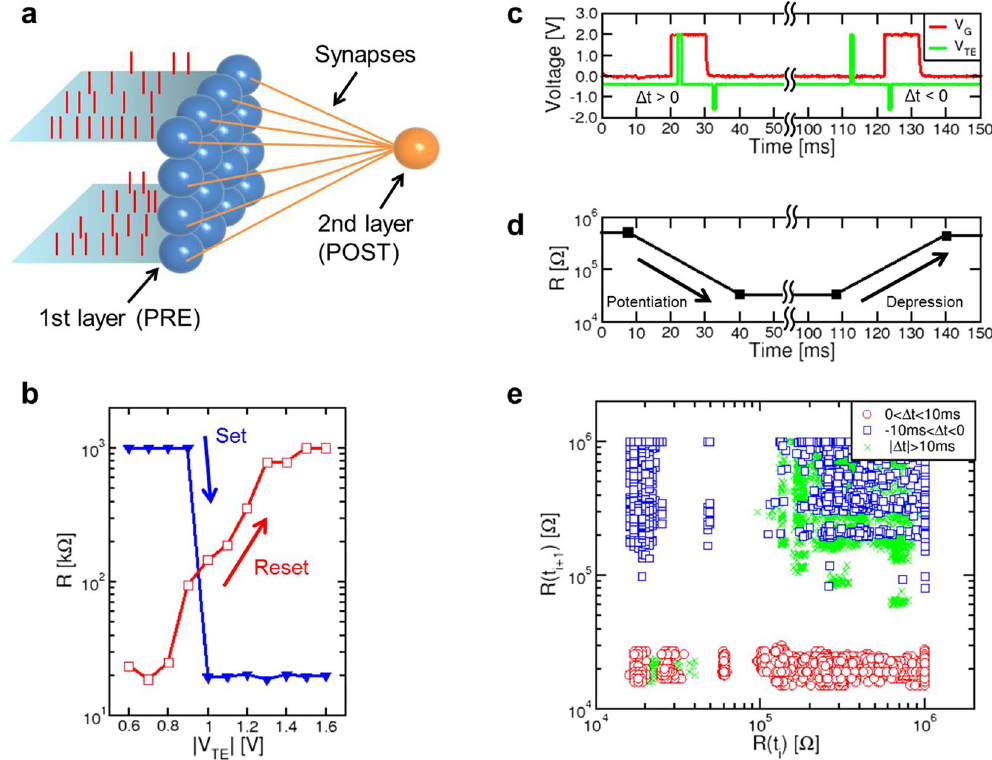
Figure 2. Synaptic network and operation. ( a ) Schematic illustration of the perceptron-like synaptic network including 16 PREs (first layer) and 1 POST (second layer), connected one to each other by 16 synapses. ( b ) Set/ reset characteristics, namely synaptic R measured after the application of a 1 ms-long pulse, as a function of the pulse voltage. Set and reset characteristics were collected after preparing the synapse in the HRS and LRS, respectively. ( c ) Measured gate voltage V G and top electrode voltage V TE , indicating the PRE spike and the POST backward spike, respectively, and ( d ) measured R before and after each pair of pulses, indicating potentiation for 0 < Δ t < 10 ms and depression for − 10 ms < Δ t < 0. ( e ) Correlation plot showing the resistance R(t i + 1